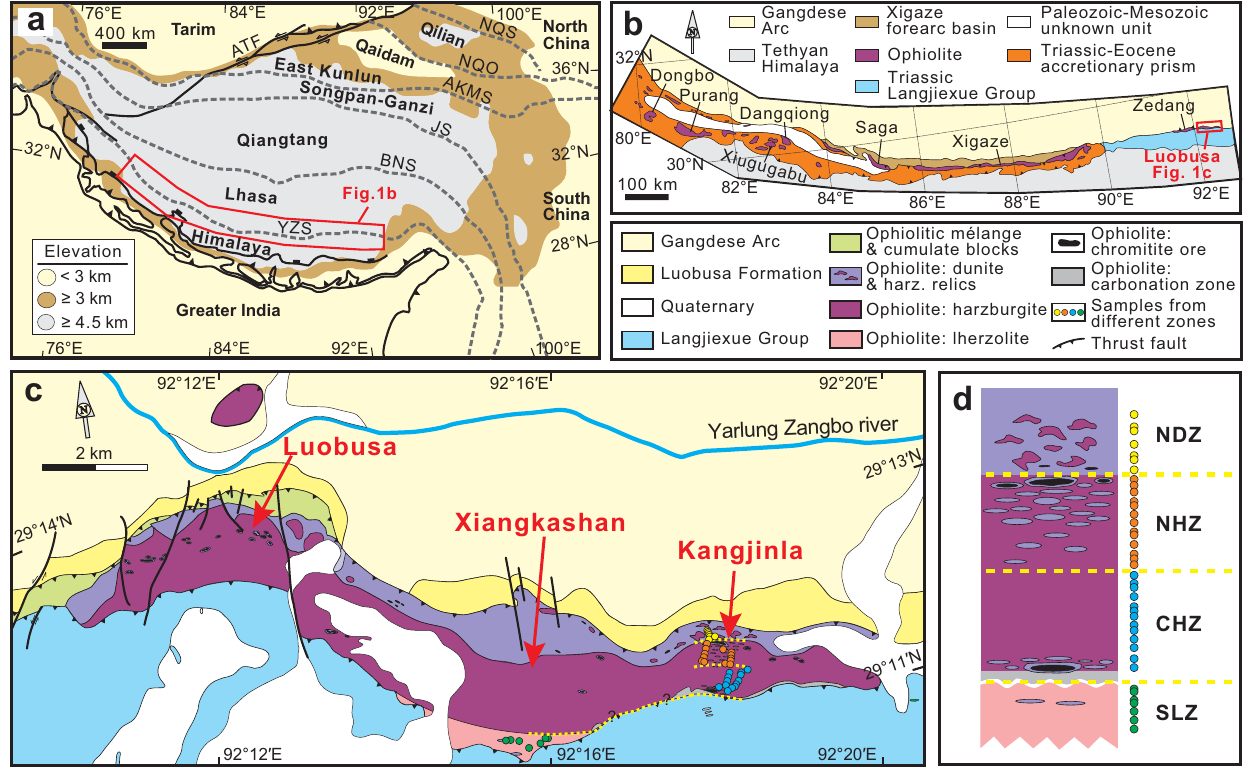
meters. The studied segments were then reconstructed as four zones ( d ), from north to south including the northern dunite zone (NDZ), northern harzburgite zone (NHZ), central harzburgite zone (CHZ) and southern lherzolite zone (SLZ). The four zones can represent the major architecture of the ophiolitic mantle, and constructa mantlepro fi lede fi ned as “ the Kangjinla ophioliticmantle ” inthisstudy ( d ). Yellow dashed curves in c and d mark the suggested boundaries between the four zones, and circles with different colors show the sampling positions. YZS Yarlung Zangbo Suture, BNS Bangong-Nujiang Suture, JS Jinsha Suture, AKMS Anyimaqen-Kunlun-MuztaghSuture,NQONorthQaidamOrogen,NQSNorthQilian Suture, ATF Altyn Tagh